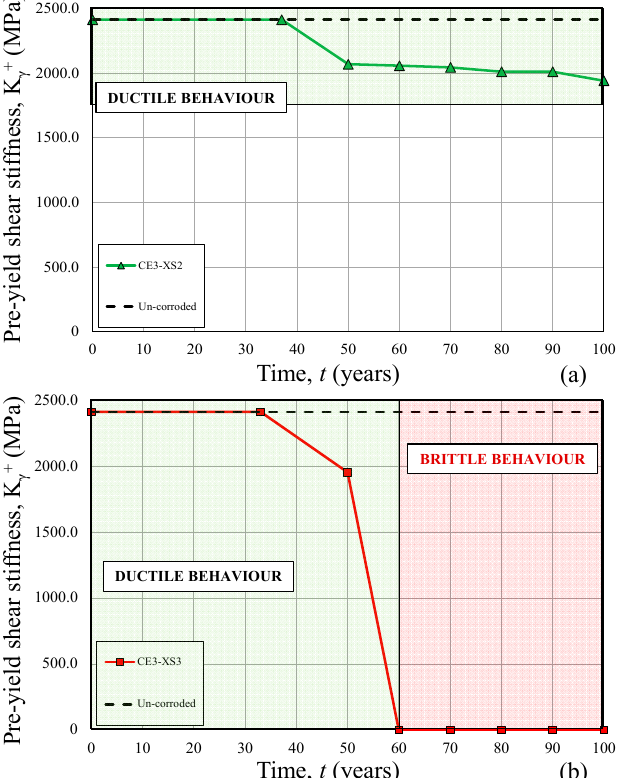
Figure 9. Positive pre-yield shear stiffness, K γ + , reduction over time for different exposure classes in case of panel CE3: ( a ) exposure class XS2, and ( b ) exposure class XS3.